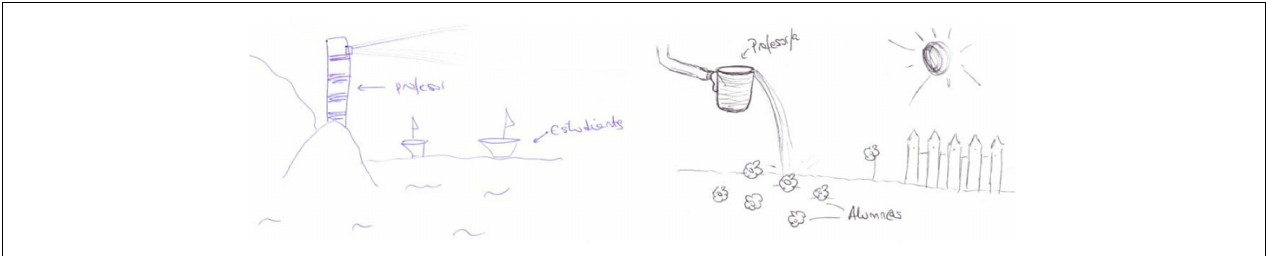
FIGURE 5 | E23’s drawings for the metaphors of a lighthouse that guides boats (pre-test) and watering the flowers (post-test).